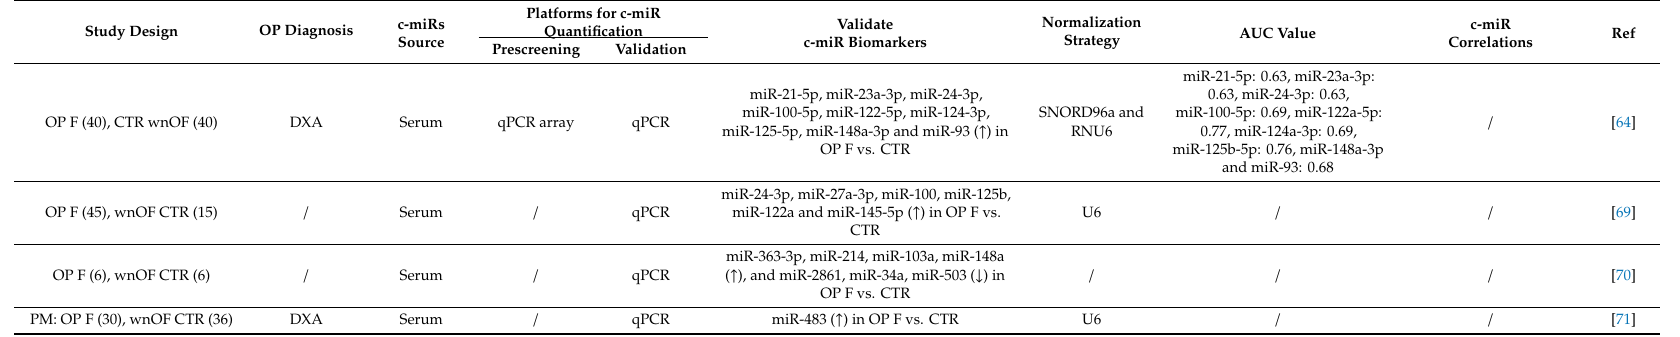
Table 3. Overview of studies that identified c-miRs as biomarkers to distinguish OP patients wF from CTRs